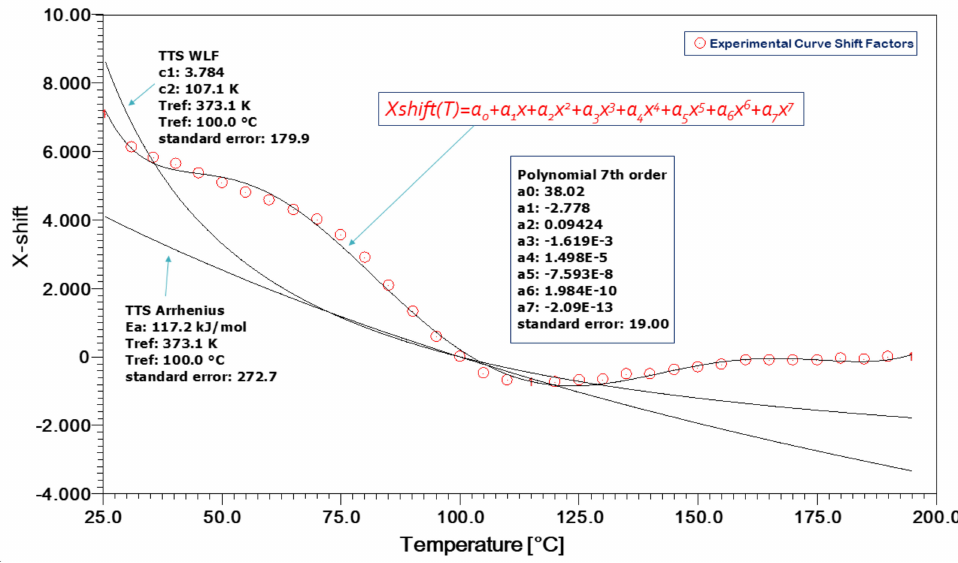
Figure 9. Vectran/aluminum–glass composite hybrid shift factors α